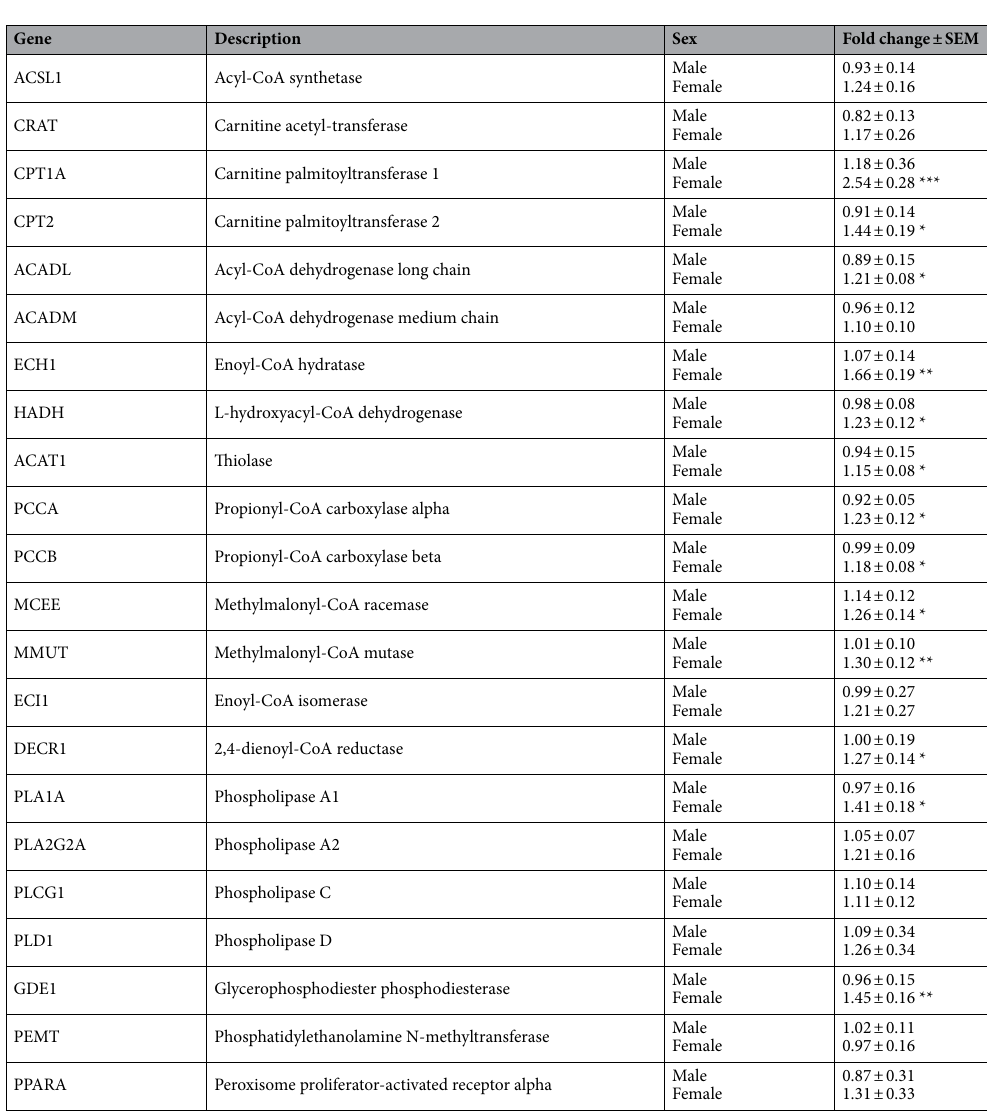
Table 3. Glycerophospholipid general lipid metabolism gene panel RT-qPCR results. mRNA levels in the livers of 19 week old prenatally DEX-exposed offspring relative to saline control. Fold changes in gene expression were calculated by relative quantification (ΔΔCt) of RT-qPCR threshold cycles (Ct) as per Livak and Schmittgen 28 using mean Ct values of housekeeping genes GAPDH and Rpl32. Data is expressed as mean fold change of Dex relative to the saline group ± SEM (n = 8). Unpaired t-test: Statistical significance between groups is shown by: * p < 0.05, ** p < 0.01, *** p <